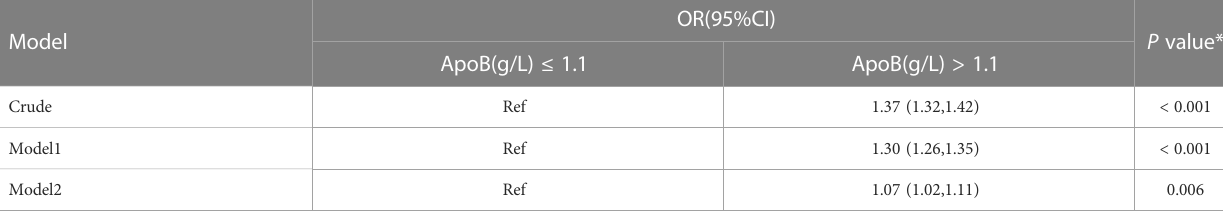
TABLE 2 Association between ApoB and the prevalence of CKD in the cross-section population.